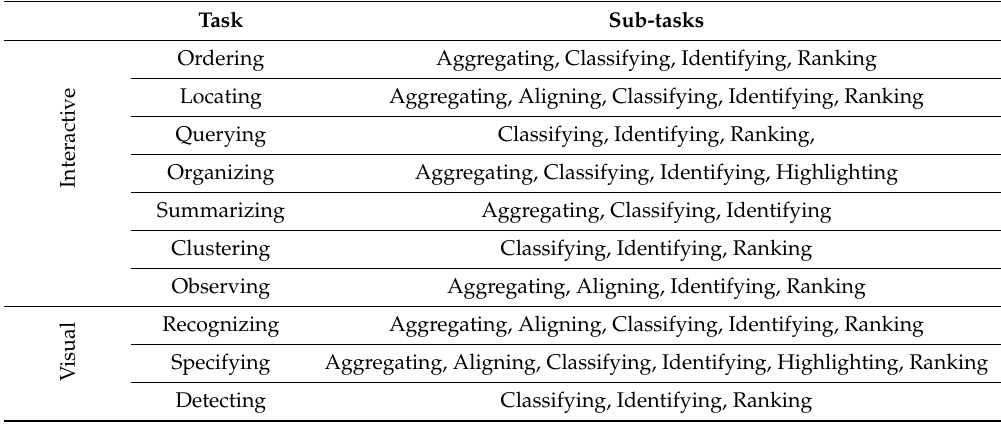
Figure 2. Overview of the proposed activity and task analysis framework. The visual tasks are represented as blue and interactive tasks are represented as yellow. Table 1. Shows the breakdown of the interactive and visual tasks.